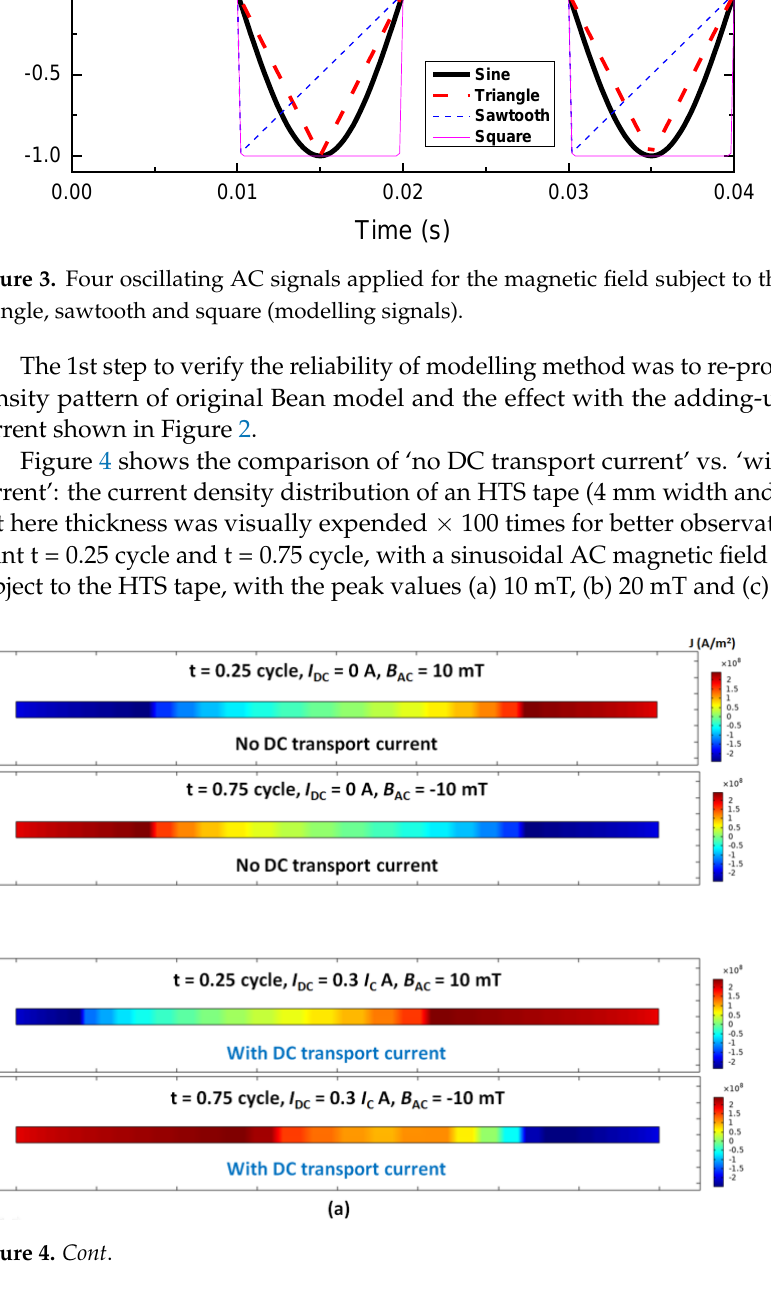
Figure 3. Four oscillating AC signals applied for the magnetic field subject to the HTS tape: sine, triangle, sawtooth and square (modelling signals).